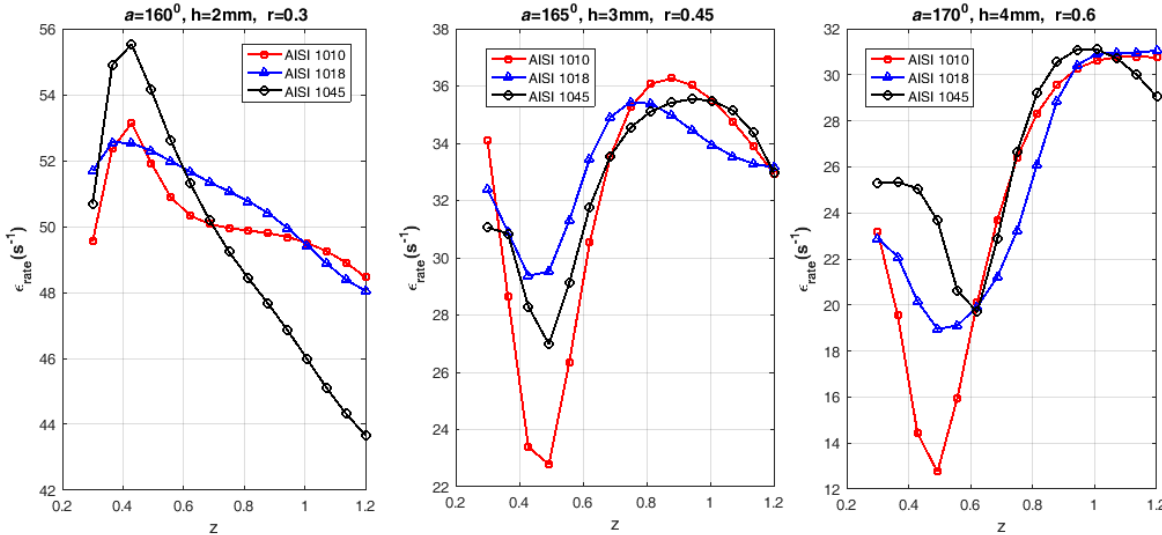
Figure 10. Comparison of forming response: effective strain rate.